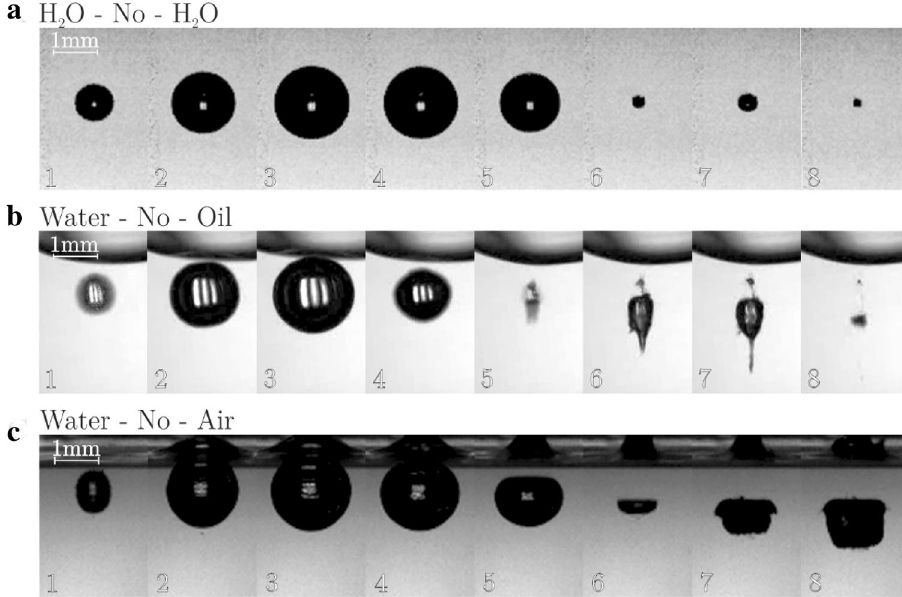
Figure 2. Typical bubble evolution for ( a ) water-water (unbounded bubble), ( b ) water–oil, ( c ) water–air interface at γ = 0.7.